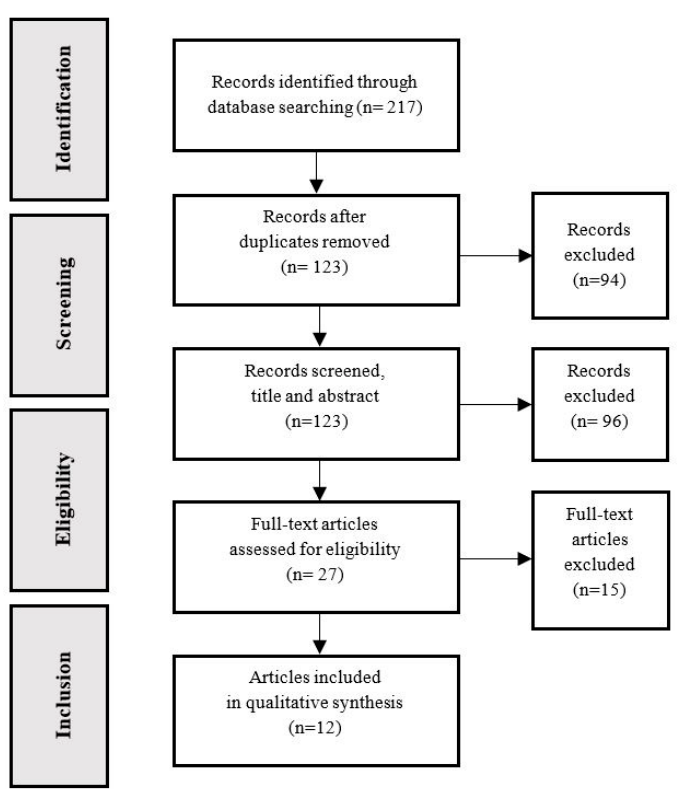
Figure 1. Flowchart. Figure 1.